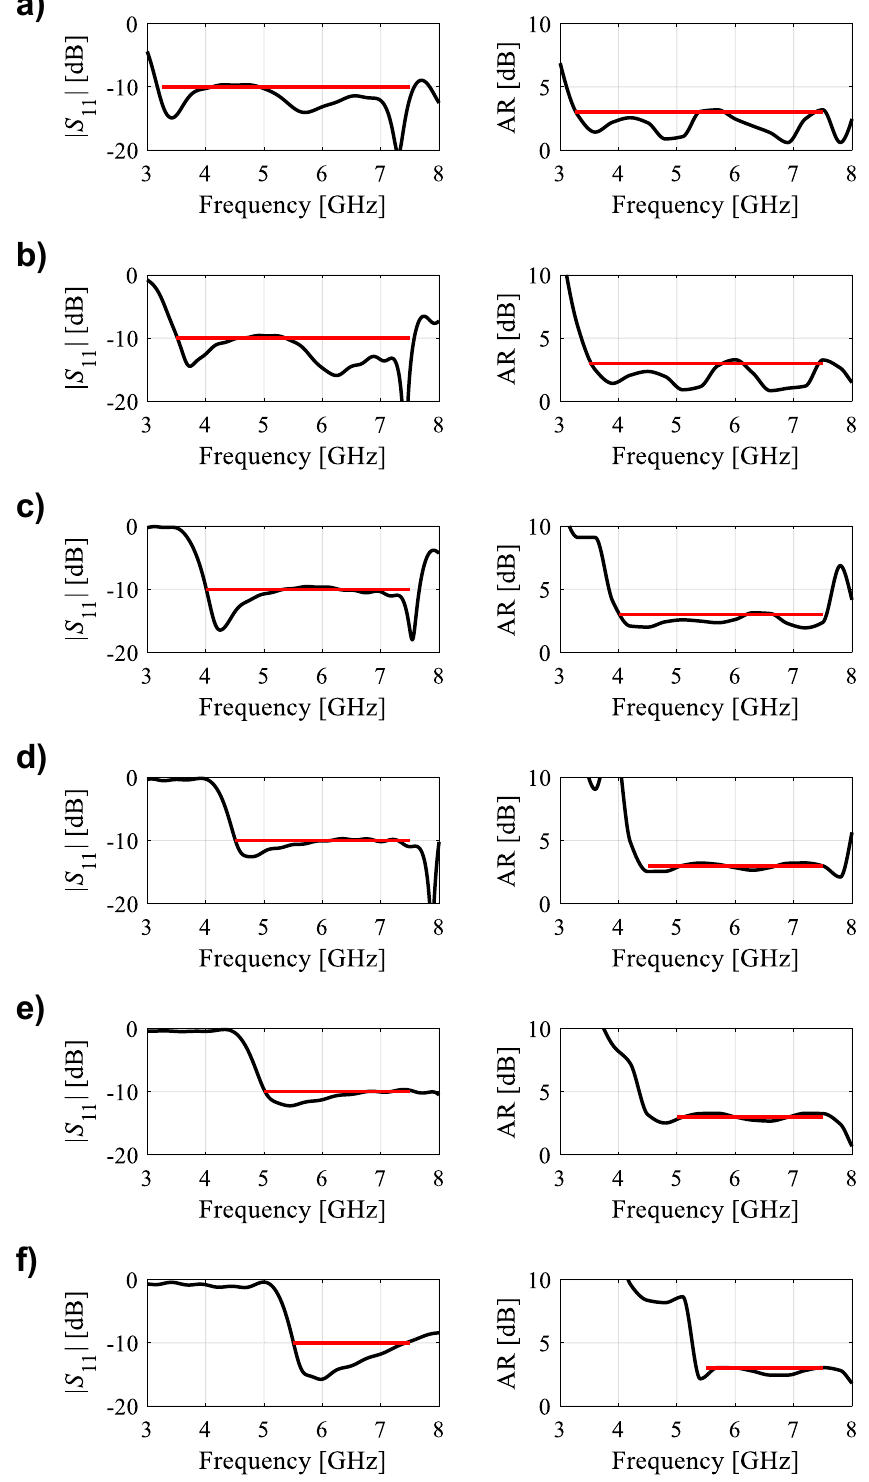
Figure 6. Trade-off designs for the CP antenna of Fig. 4: reflection (left) and axial ratio (right) responses. Horizontal lines represent the target operating bandwidth: ( a ) f L = 3.25 GHz, ( b ) f L = 3.5 GHz, ( c ) f L = 4.0 GHz, ( d ) f L = 4.5 GHz, ( e ) f L = 5.0 GHz, ( f ) f L = 5.5